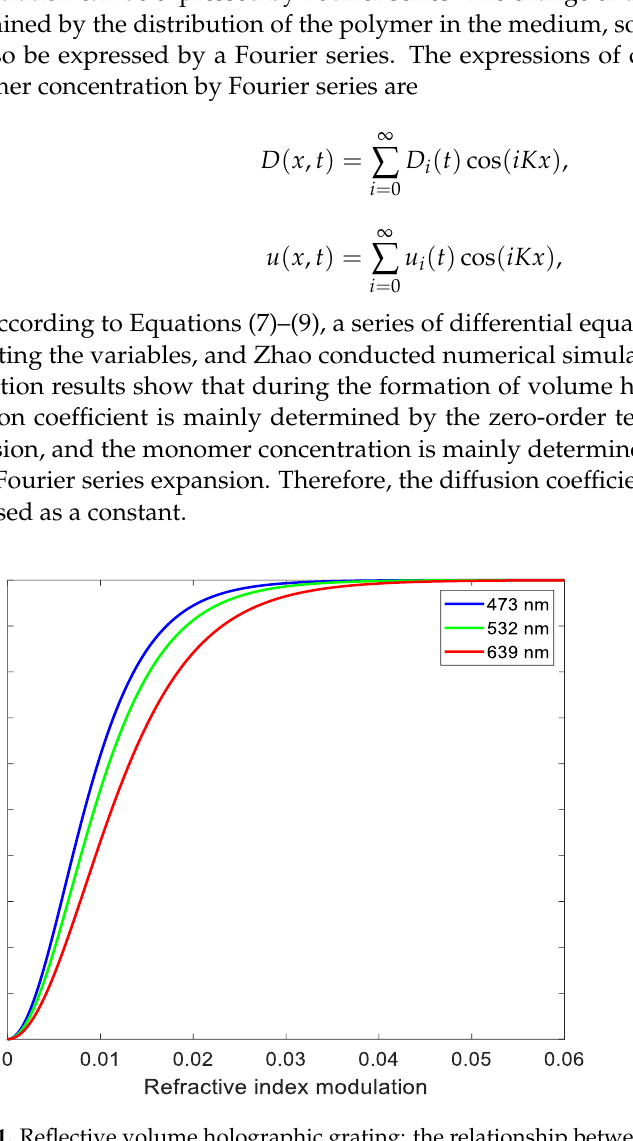
Figure 1. Reflective volume holographic grating: the relationship between refractive index modulation and diffraction efficiency.